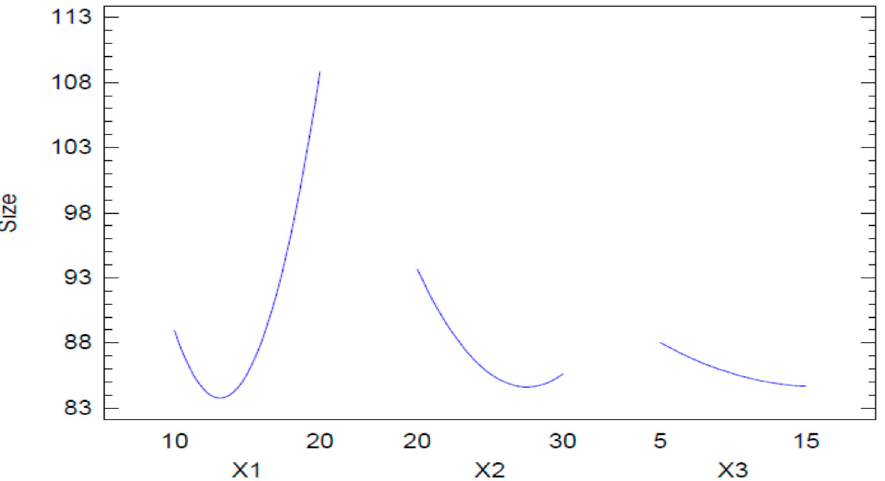
Figure 3. Main effects plot for globule size.